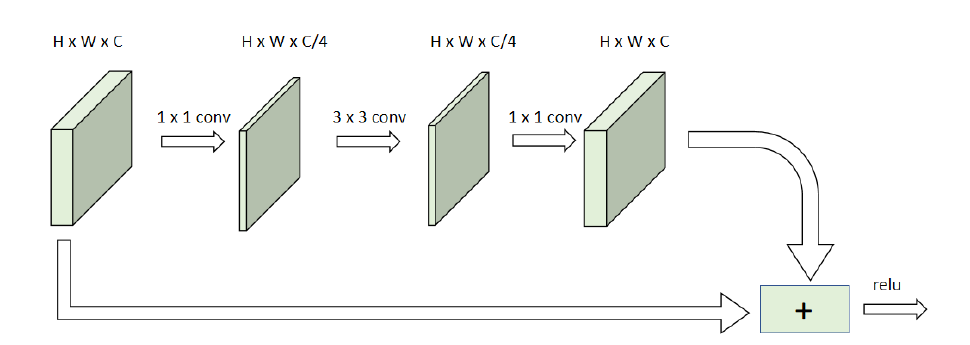
Figure 2. The architecture of a residual